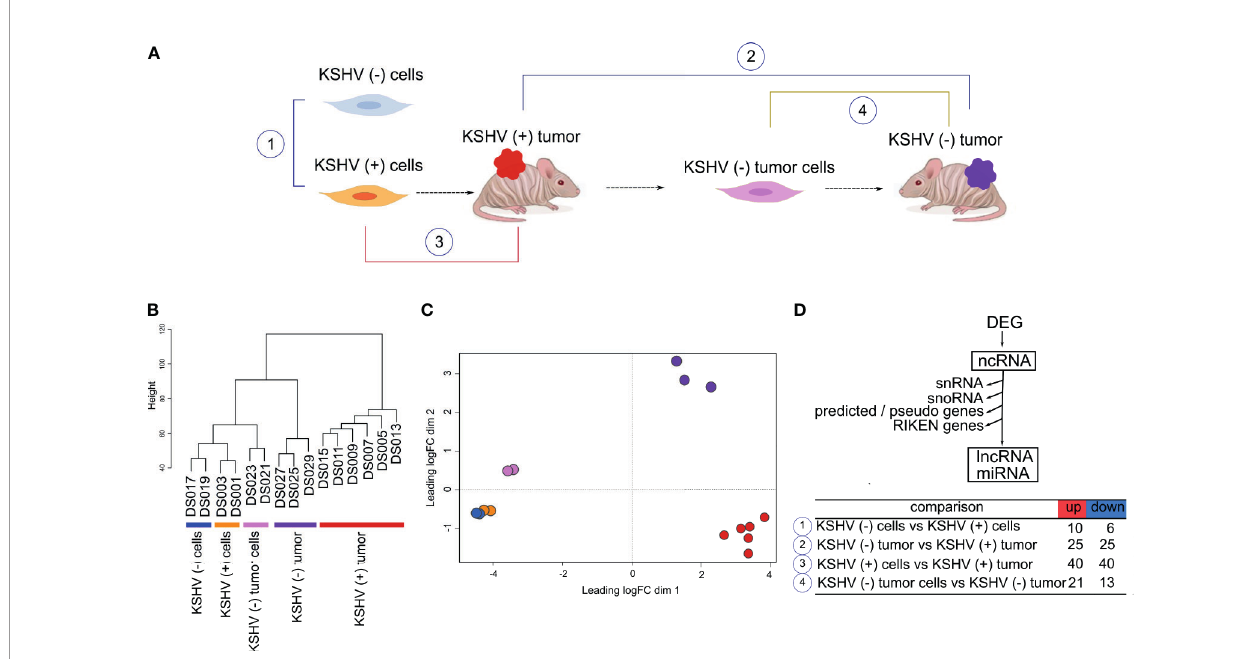
FIGURE 1 | Genome-wide analysis of Non-coding RNAs in a cell and animal model of Kaposi ’ s Sarcoma. (A) Schematic representation of the mouse-KS cell and tumor model. (B) Unsupervised clustering of the host ncRNA transcriptome. (C) Multidimensional scaling plot of the host ncRNAs showing the distance of each sample from each other determined by their leading log Fold Change (FC). (D) Work fl ow analysis and number of DE lncRNAs in key biological comparisons that were detected by RNA-sequencing analysis of: two KSHV (+) cells, two KSHV ( − ) cells, six KSHV (+) tumors, two KSHV ( − ) tumor cells and three KSHV ( − )